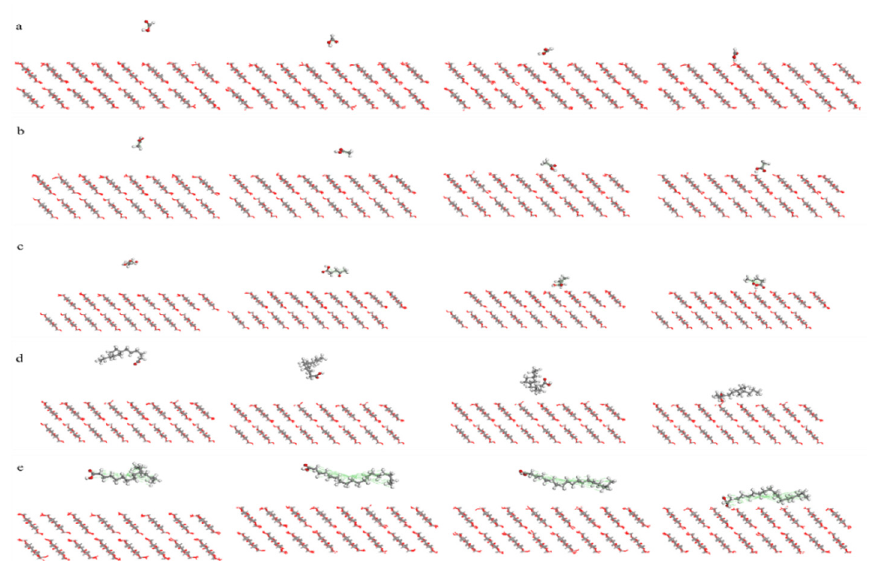
Figure 2. Adsorption process of different acid molecules at 0 ps, 25 ps, 50 ps and 100 ps. ( a ) Formic acid; ( b ) Acetic acid; ( c ) Levulinic acid; ( d ) Naphtenic acid; ( e ) Stearic acid.